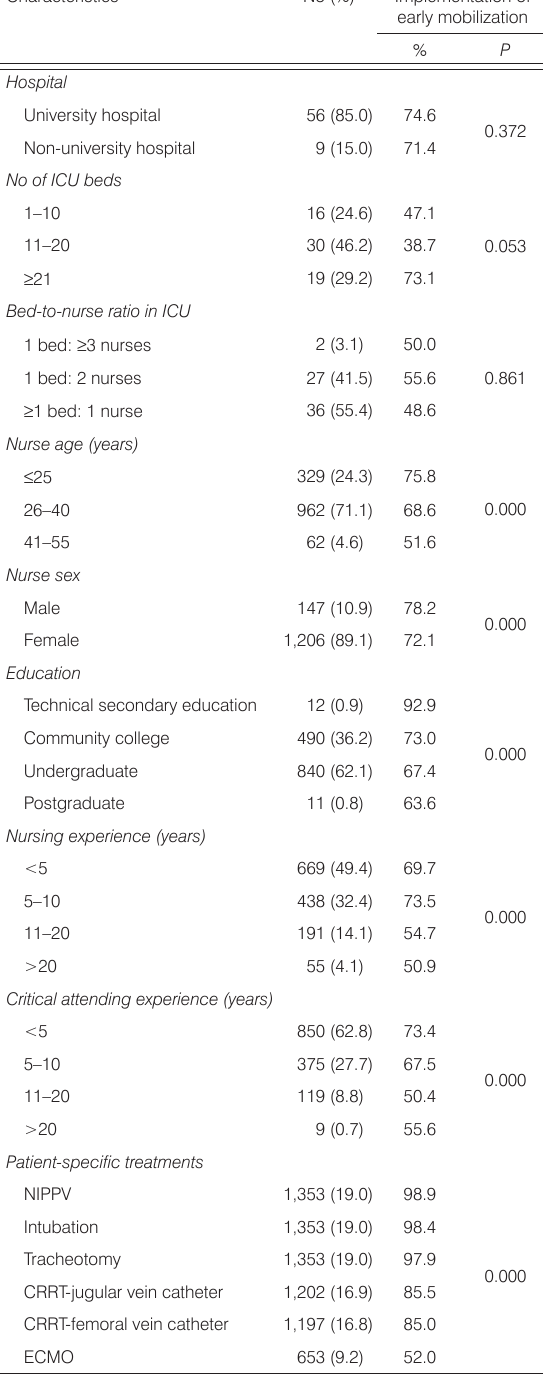
Table 1. Baseline organizational characteristics and patient-specific treatments with the implementation of early mobilization in